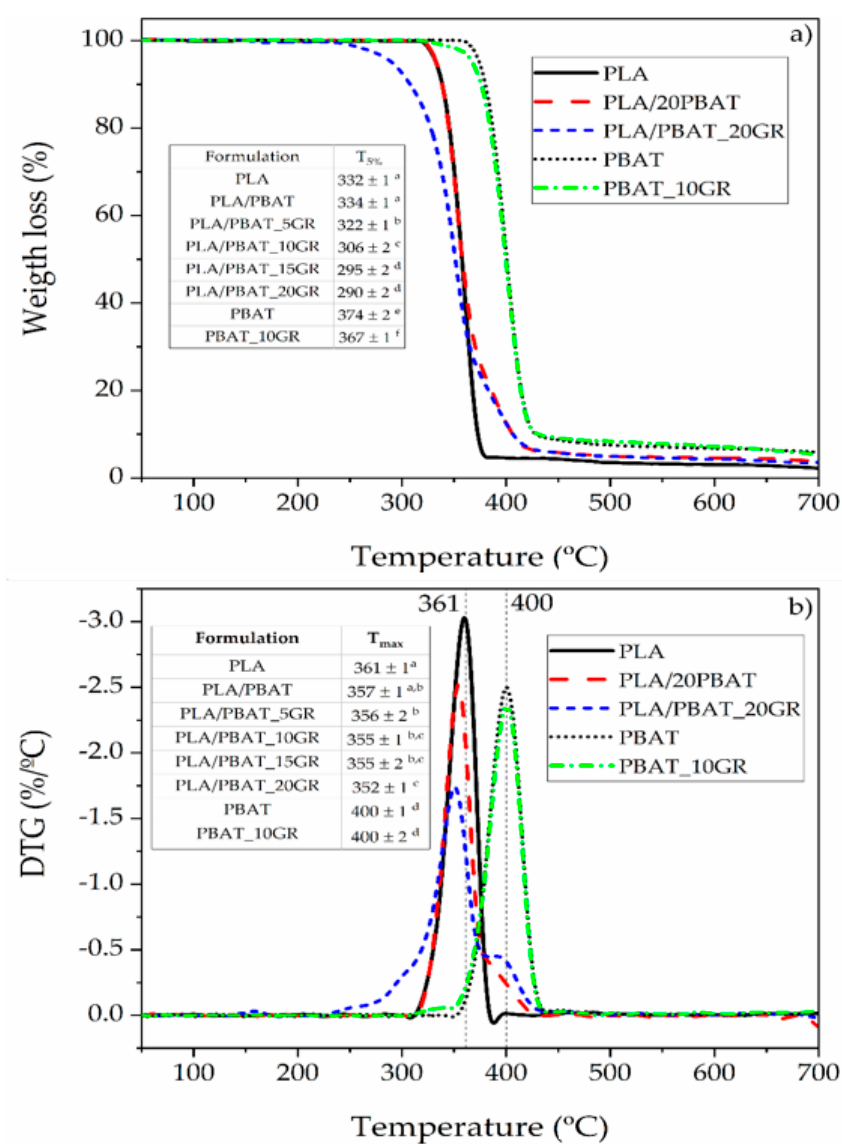
Figure 6. ( a ) TGA and ( b ) DTG curves of PLA and PBAT matrixes, and studied representative blends: PLA/PBAT, PLA/PBAT_20GR, and PBAT_10GR. a–f Different letters within the same property show statistically significant differences between formulations ( p < 0.05).